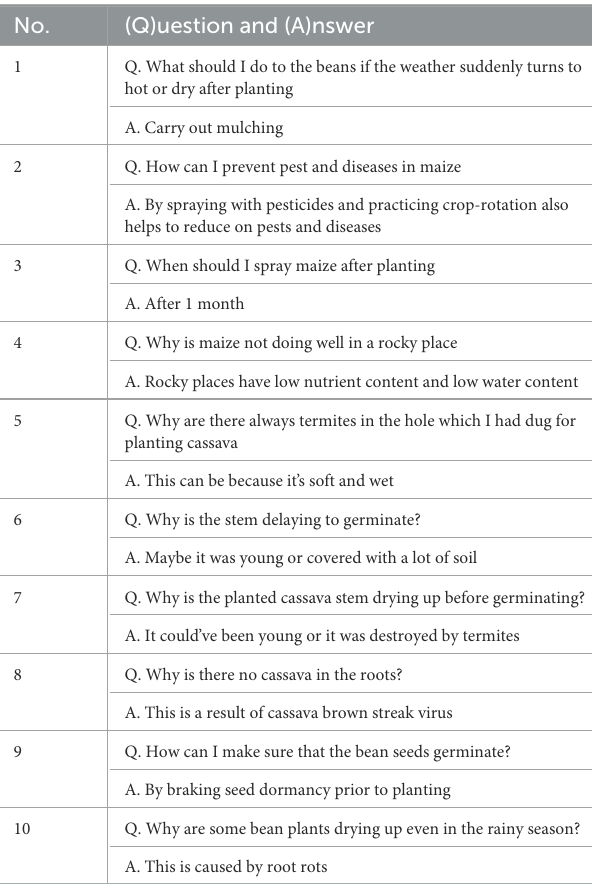
TABLE 1 A sample of 10 questions (Q) and their corresponding answers (A) from experts are extracted from the training dataset.